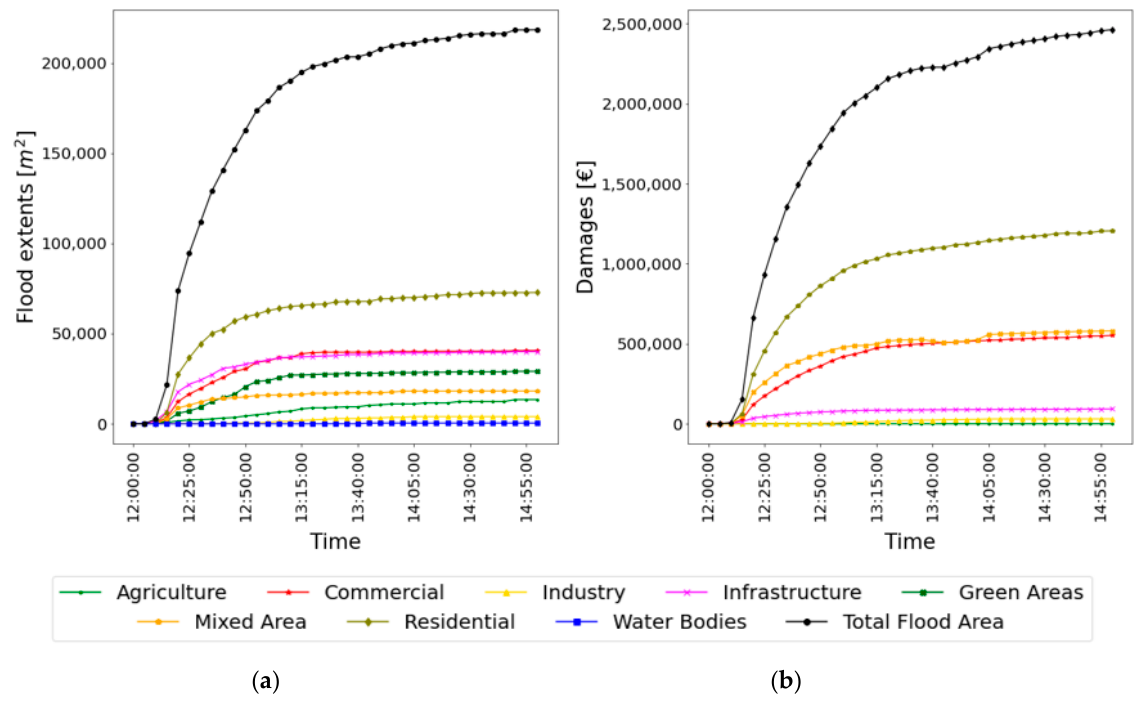
Figure 3. Time series of propagation of flood extents and its impacts for a 50-year return period design storm event. ( a ) Flood extents in [m 2 ] ( b ) Damage estimation in [€].